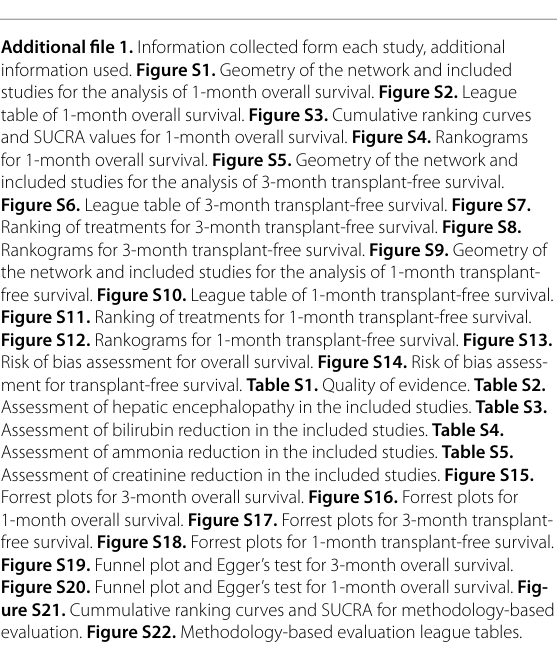
Figure S20. Funnel plot and Egger’s test for 1-month overall survival. Fig- ure S21. Cummulative ranking curves and SUCRA for methodology-based evaluation. Figure S22. Methodology-based evaluation league